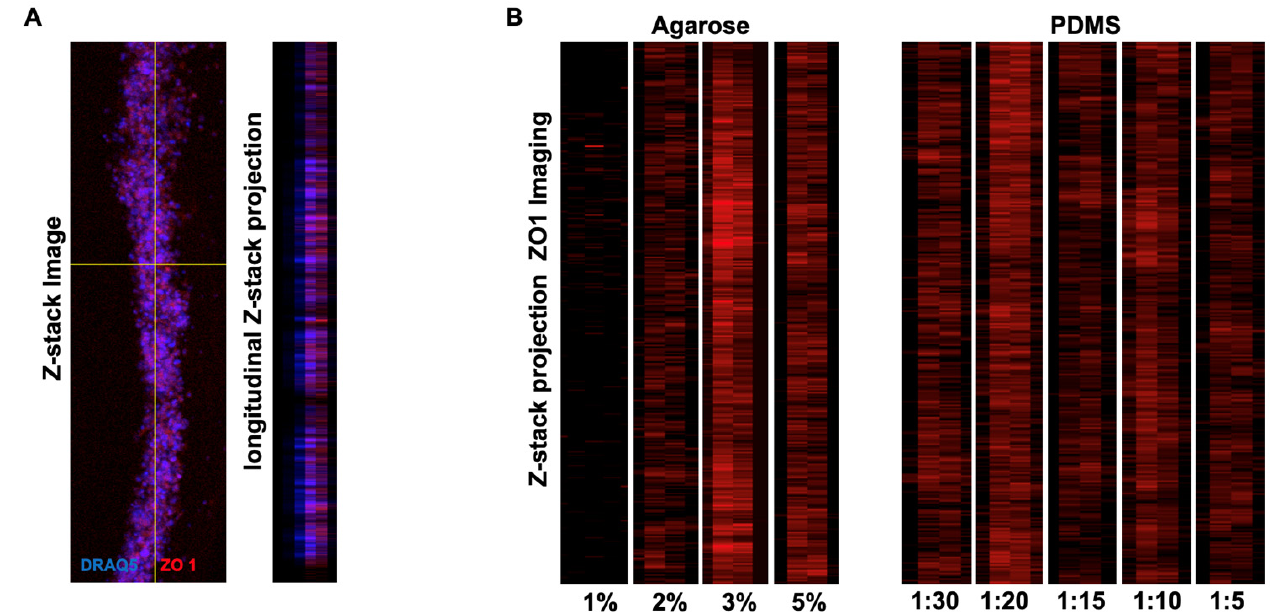
Figure 6. ( A ) Representative confocal image of the tubular structure stained for polarization marker ZO-1 ( red ) and DRAQ5 ( blue ). Longitudinal Z-stack projection on the right panel. Tubes were harvested after 24 h from agarose substrates of different stiffness and stained for ZO-1 ( red ) and measured using Image J2 software 1.52 ( B ) A representative longitudinal Z-stack projection of ZO-1 ( red ) stained tubes generated on agarose and PDMS substrates of different concentrations or dilutions, respectively. The ZO-1 intensity was measured using Image J.